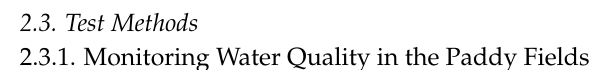
Table 1. Detailed list of contents of each experimental feed.